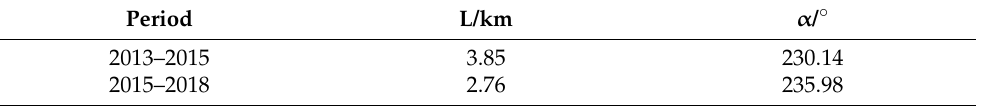
Table 2. The moving distance L and angle α of the center of gravity of urban area hotspots in Wuhan from 2013 to 2018.